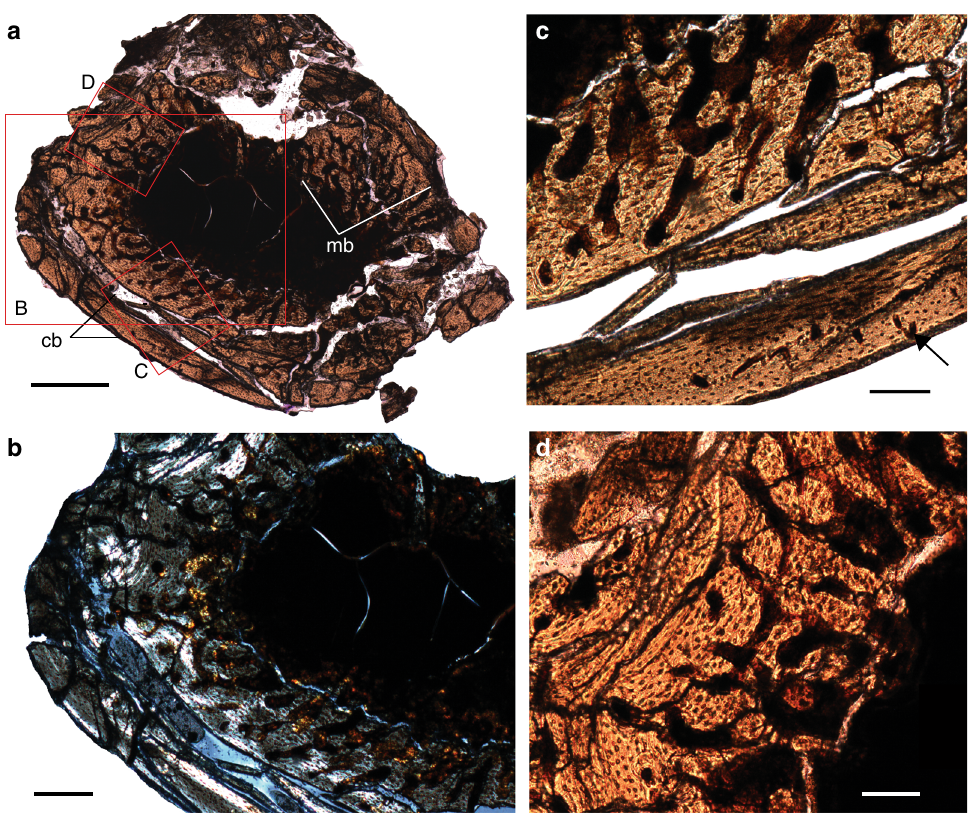
Fig. 3 Osteohistology of the tibiotarsus of pengornithid IVPP V15576. a Full cross-section; b close up under polarized light; c close up of the longitudinal canal near the periosteal surface (black arrow) indicating active growth; d close up showing radial vascular canals and spicular trabeculae of the MB. Scale bar in a equals 500 µ m; scale bar in b equals 200 µ m; scale bars in c and d equal 100 µ